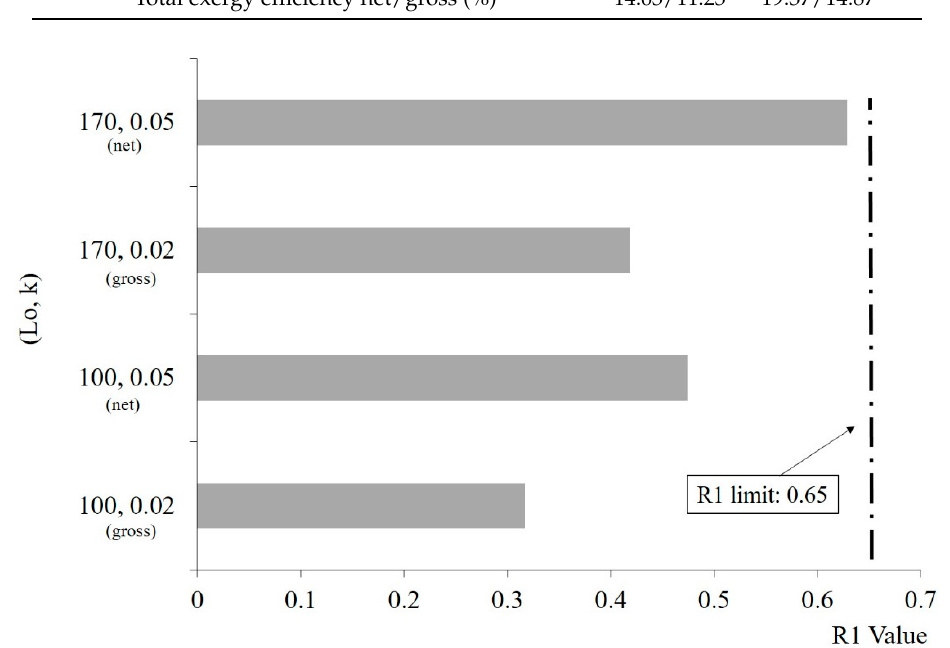
Figure 4. R1 values for CHP from the simulated landfill gas.